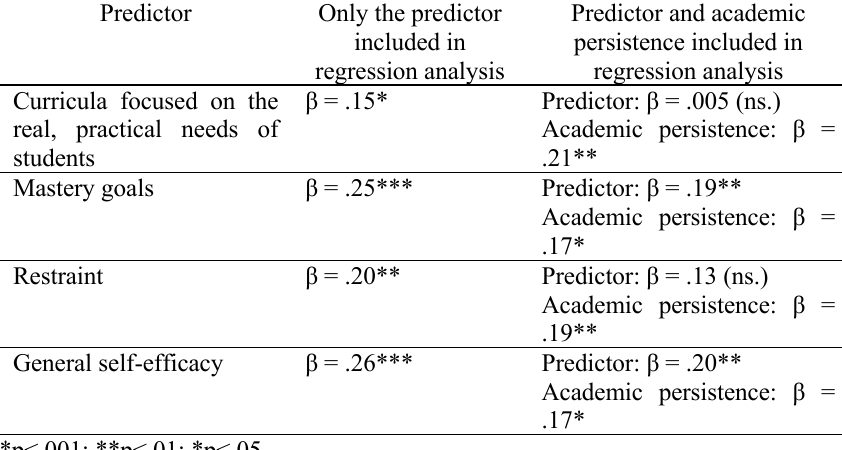
Table 1. Results of the mediation analysis with Academic performance as outcome in the IB